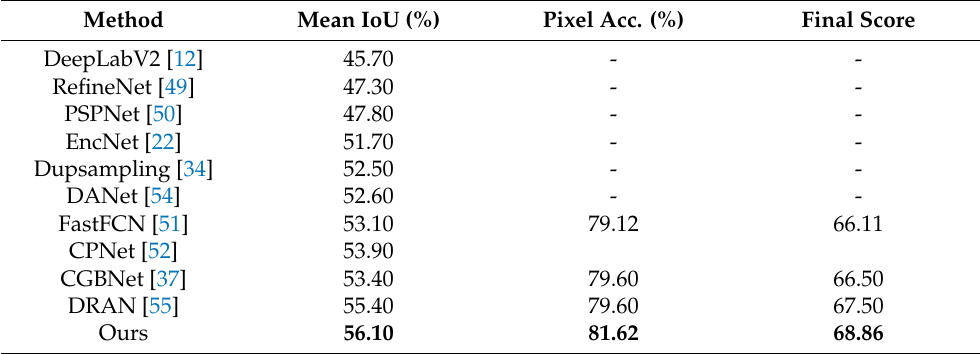
Table 3. Comparison with state-of-the-art methods on Pascal-Context dataset. Our method outper- forms the